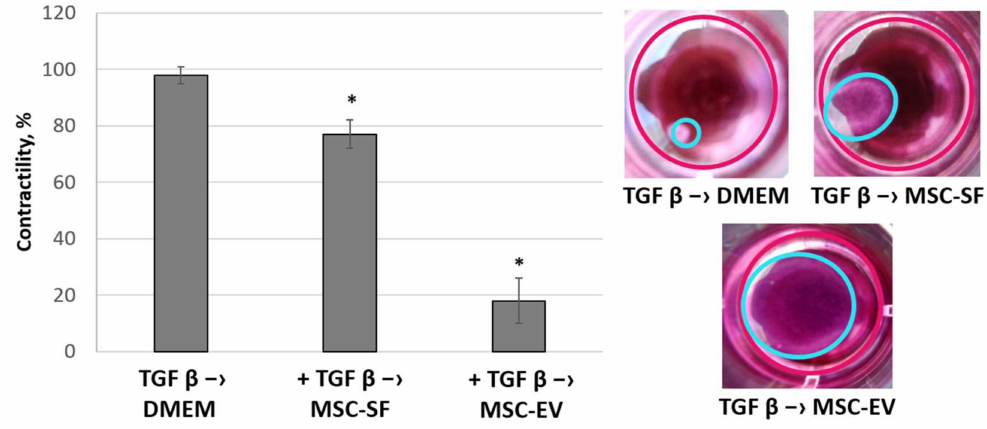
Figure 7. MSC-CM fractions added after the TGFbeta treatment reversed the TGFbeta-stimulated contractile activity of fibroblasts. Changes in the functional activity of the fibroblasts after exposure to TGFbeta ( + TGFbeta) and the subsequent replacement of growth medium by the components of MSC-CM ( + TGFbeta – > MSC-EV; + TGFbeta – > MSC-SF) or control serum-free DMEM ( + TGFbeta – > DMEM). Collagen contraction assay. * p < 0.05 (compared to TGFbeta – > DMEM group).